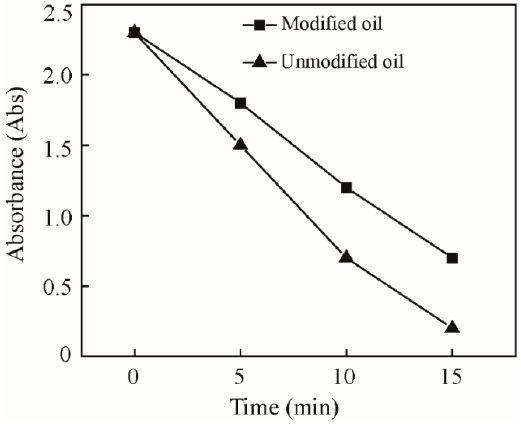
Figure 3. Absorbency curve of the oil with time.